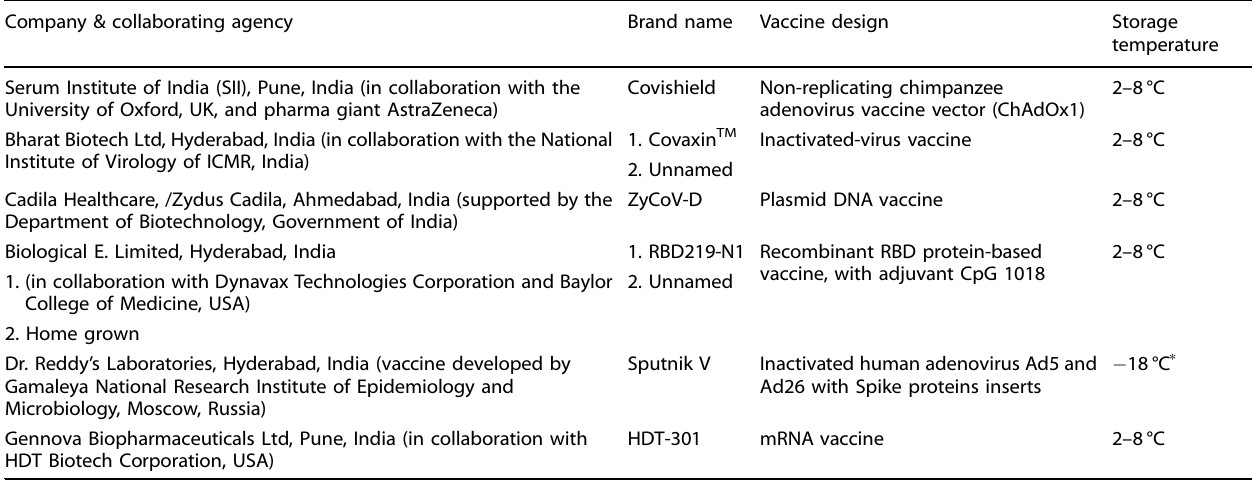
Table 1. Potential vaccine candidates in